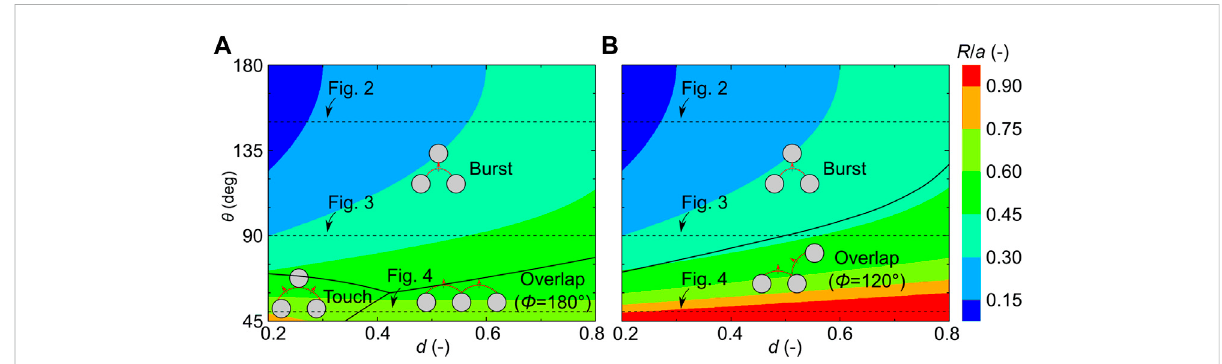
FIGURE 1 Transitionofpore- fi llingeventsandtheircriticalradiiofcurvatureonthe d - θ plane,with d rangingfrom0.2to0.8and θ rangingfrom45 ° to180 ° . We consider cooperative pore- fi lling events with Φ = 180 ° (A) and Φ = 120 ° (B) . Regions of pore- fi lling events are separated by black lines. The normalized critical radii of curvature R / a are presented with red for a higher value and with blue for a lower value. We present the transition of pore- fi lling events and their critical radii of curvature in detail at θ = 50 ° , 90 ° , and 150 ° (dash lines), as shown in Figures 2 – 4.